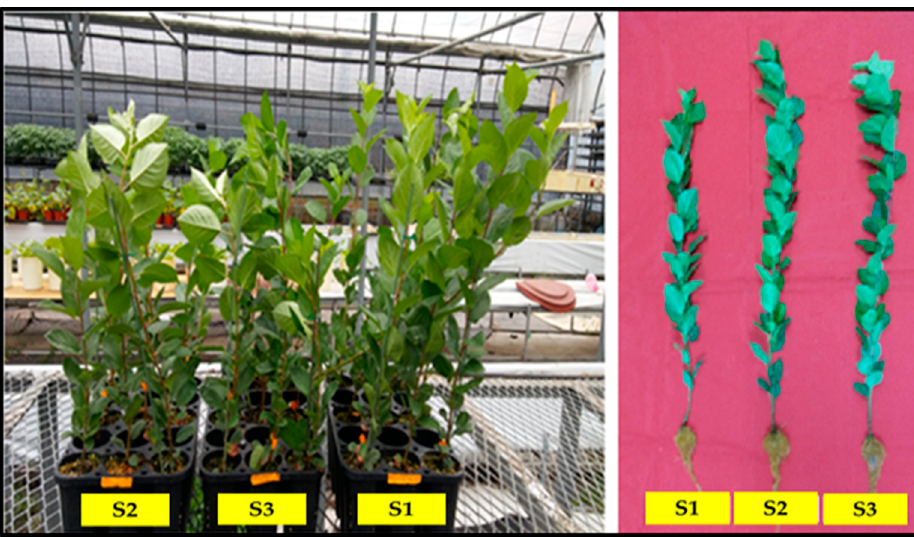
Figure 2. Effect of substrate composition on the growth of M-9 apple rootstock plants at 11 weeks after treatment in a greenhouse. S1, S2 and S3 indicate a 1:1:1, 1:2:3 and 3:1:2 ratio of peat moss: vermiculite: perlite, respectively.